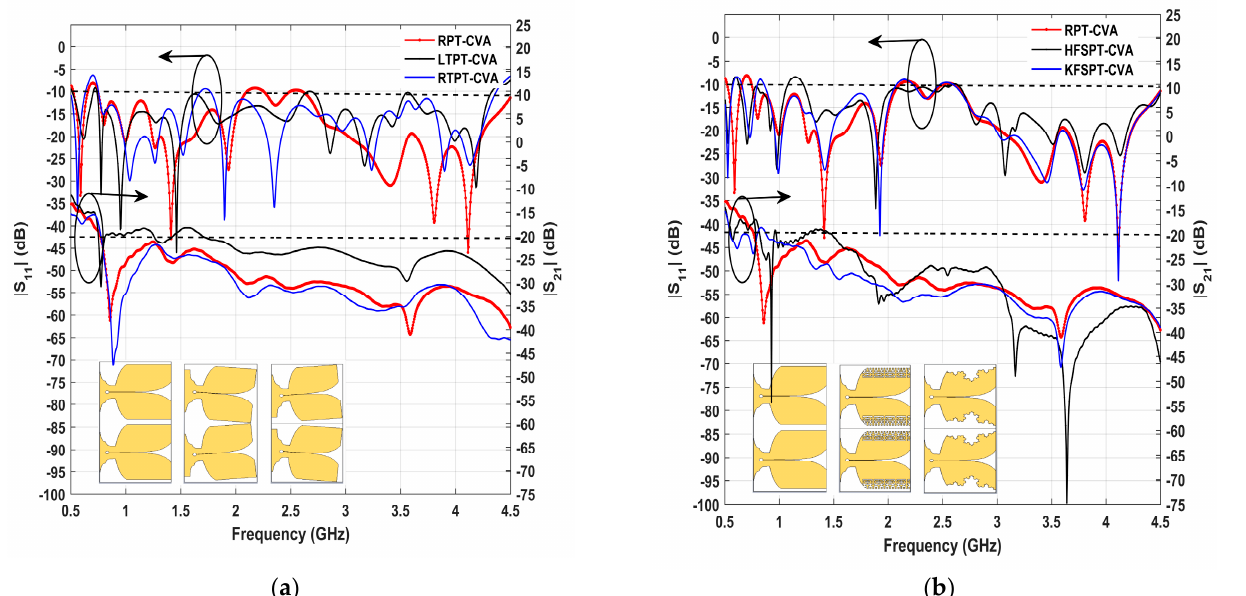
Figure 4. S 11 and S 21 performance of 1 × 2 MIMO ( a ). Regular Palm Tree-Coplanar Vivaldi Antena (RPT-CVA), Left Tilt Palm Tree (LTPT-CVA), Right Tilt Palm Tree (RTPT-CVA) and ( b ). Regular Palm Tree-Coplanar Vivaldi Antena (RPT-CVA), Hilbert Fractal Structure Palm Tree (HFSPT-CVA), Koch Fractal Structure Palm Tree (KFSPT-CVA).